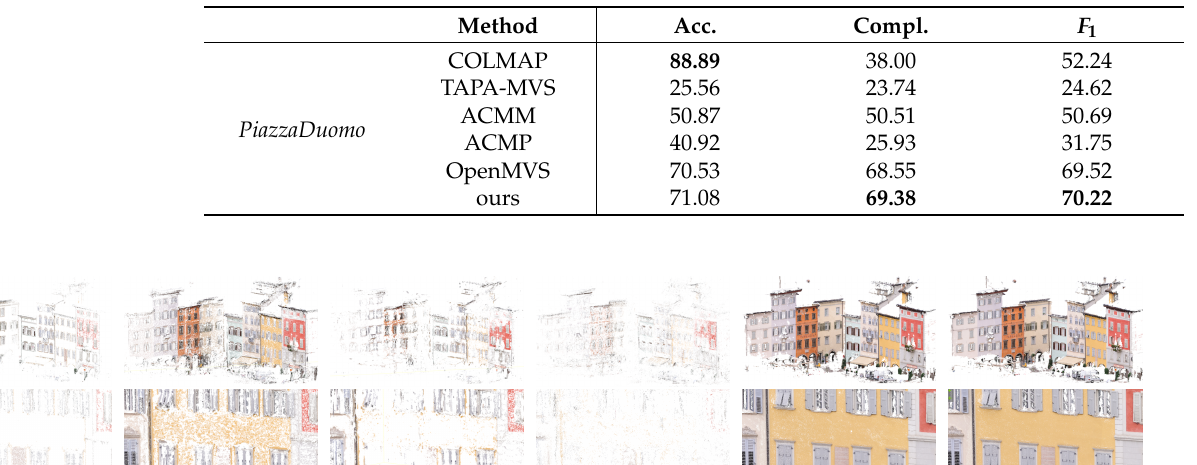
Table 2. Accuracy, completeness and F 1 score comparisons of the PiazzaDuomo dataset for τ = 10 cm.